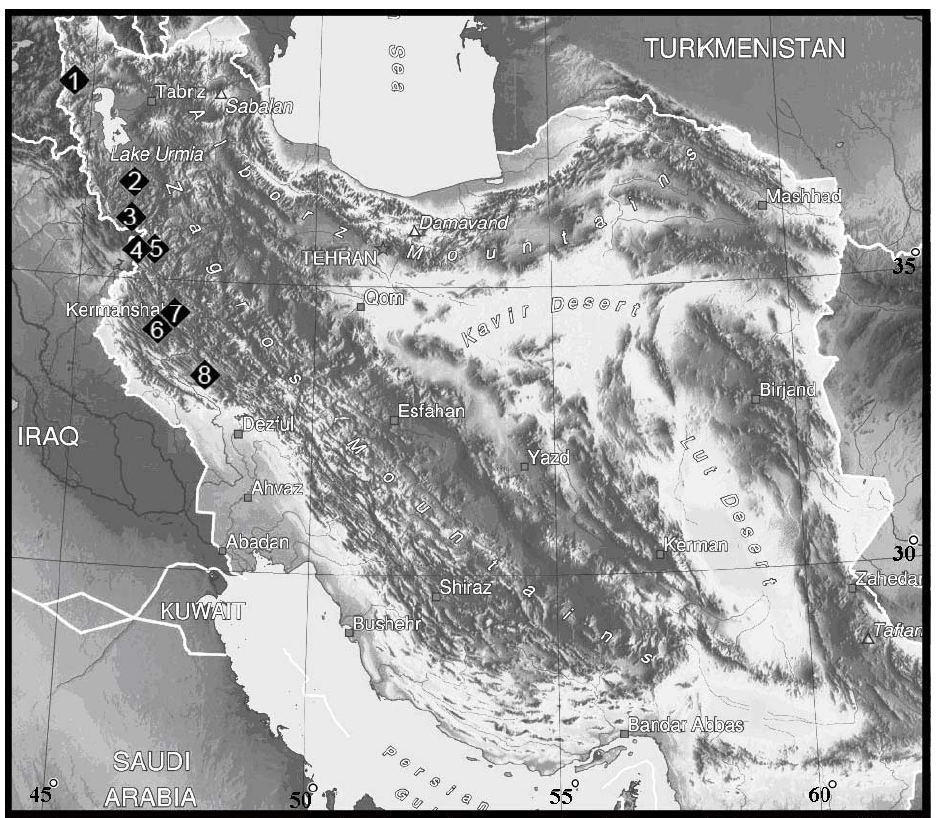
F IG . 1. Map of sampling localities for Trachylepis aurata transcaucasica specimens. West Azarbaijan Province: